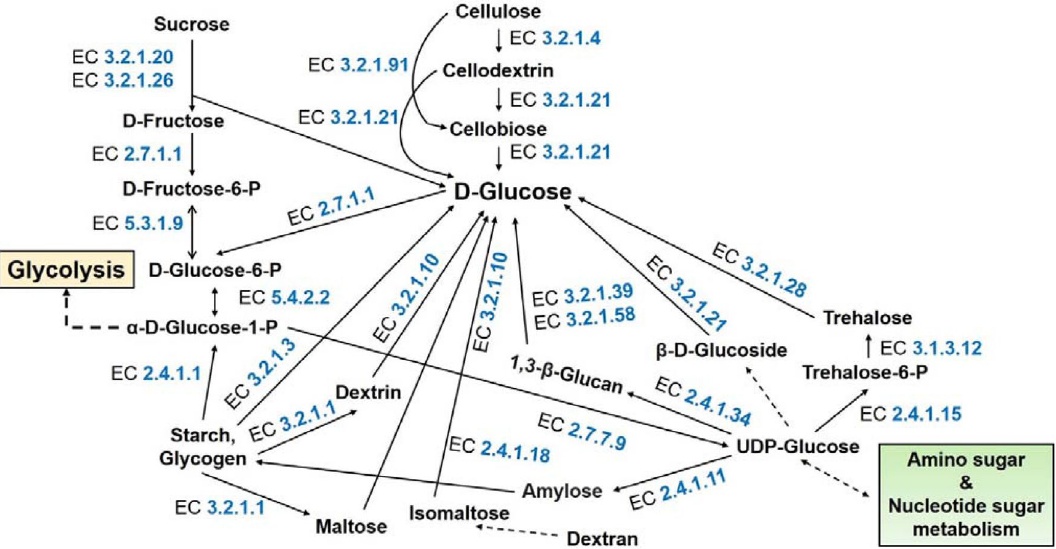
Figure 7. Starch and sucrose metabolism pathways depicting various enzymes involved including plant cell wall degrading enzymes. In here, the Sysname of enzymes related to the biosynthetic machinery are depicted in blue-colored EC numbers: The key to all of the EC numbers are as follows: EC 3.2.1.4, 4-β-D-glucan 4-glucanohydrolase; EC 3.2.1.21, β-D-glucoside glucohydrolase; EC 3.2.1.91, 4-β-D-glucan cellobiohydrolase (non-reducing end); EC 3.2.1.20, α-D-glucoside glucohydrolase; EC 3.2.1.26, β-D-fructofuranoside fructohydrolase; EC 2.7.1.1, ATP:D-hexose 6-phosphotransferase; EC 5.3.1.9, D-glucose-6-phosphate aldose- ketose-isomerase; EC 2.4.1.15, UDP-α-D-glucose:D-glucose-6-phosphate 1-α-D-glucosyltransferase; EC 3.1.3.12, α, α-trehalose-6-phosphate phosphohydrolase; EC 3.2.1.28, α, α-trehalose glucohydrolase; EC 2.4.1.11, UDP-α-D-glucose: glycogen 4-α-D-glucosyltransferase; EC 2.4.1.18, (1->4)-α-D-glucan:(1->4)-α-D-glucan 6-α-D-[(1->4)-α-D-glucano]-transferase; EC 2.4.1.1, (1->4)-α-D-glucan:phosphate α-D-glucosyltransferase;